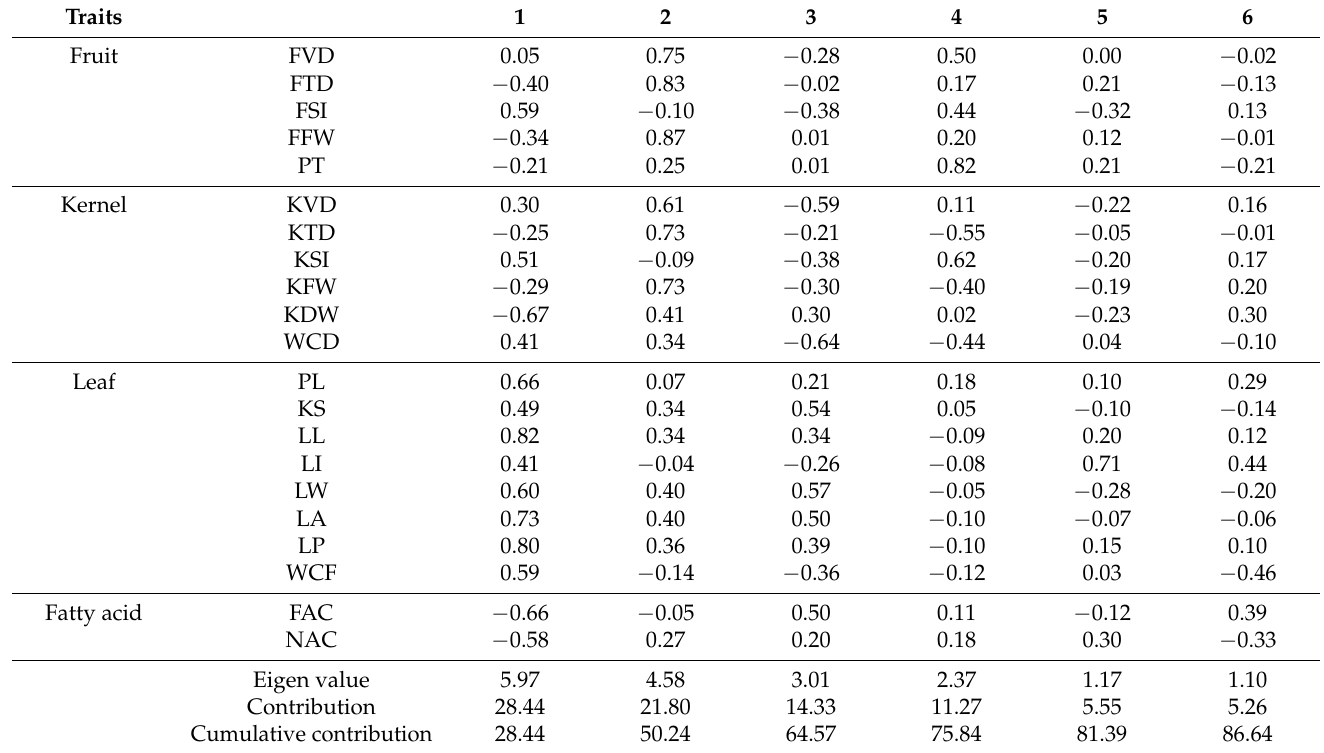
Table 4. Principal component analysis of the 21 traits.